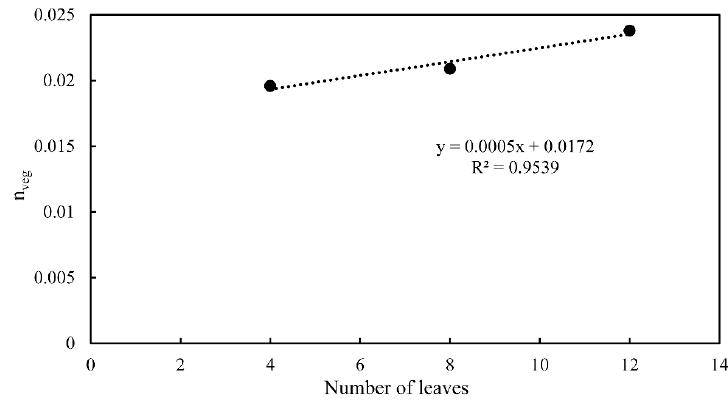
Figure 9. Relationship between the Manning’s roughness coefficient and the number of leaves.